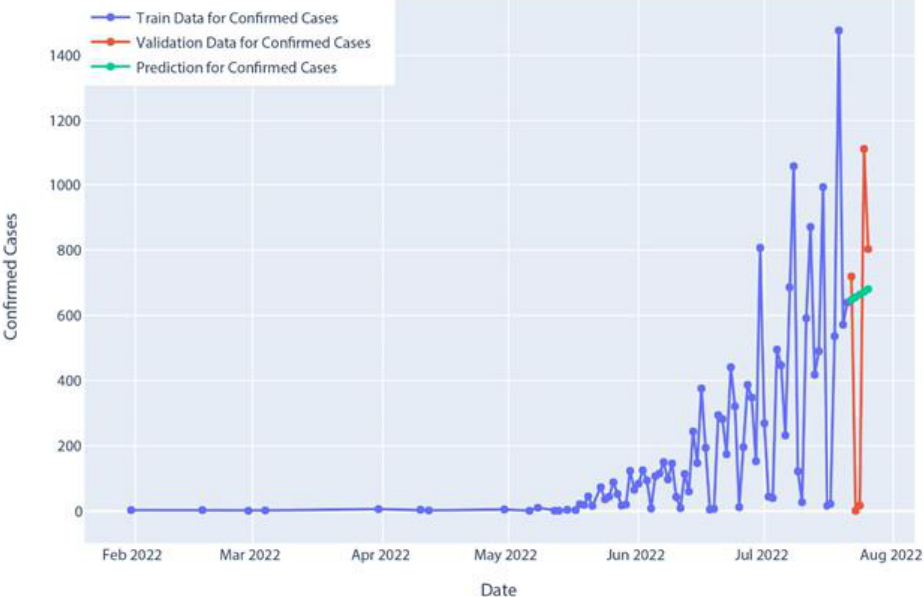
Figure 20. Confirmed cases of MA model prediction.